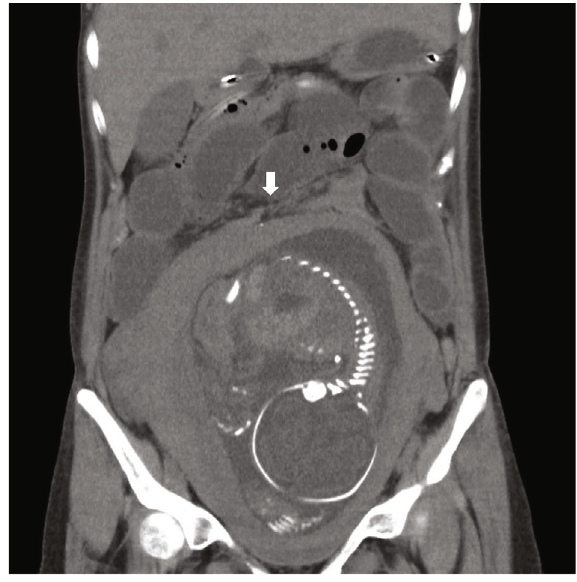
Figure 2: CT fi ndings of adhesive small intestine at 26-week gestation. An arrow indicates adhesion